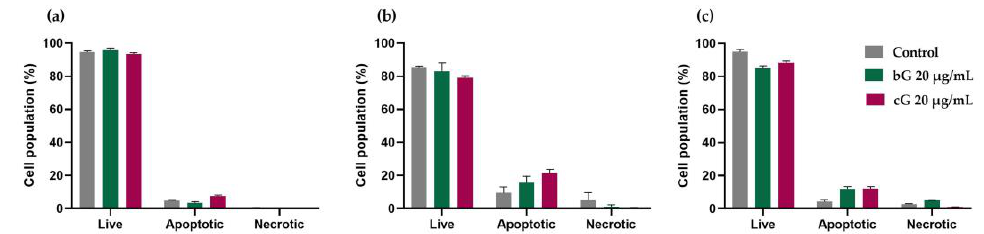
Figure 6. Depiction of the live, apoptotic, and necrotic cell population (%) in NIH/3T3 ( a ), HaCaT ( b ) and THP-1 cells ( c ) after treatment with 20 µ g/mL of either bG or cG, for 24 h. There is not enough available data related to apoptosis induced by pristine graphene. Li et al. reported that pristine graphene induces apoptosis in RAW264.7